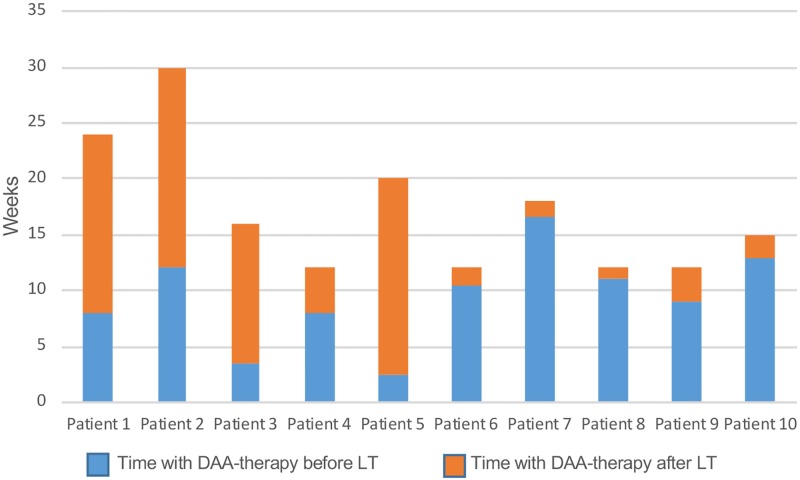
DAA treatment pre- and post-LT.DAA-treatment before and after liver transplantation. Blue and orange bars represent pre- and post-transplant therapy length, respectively.